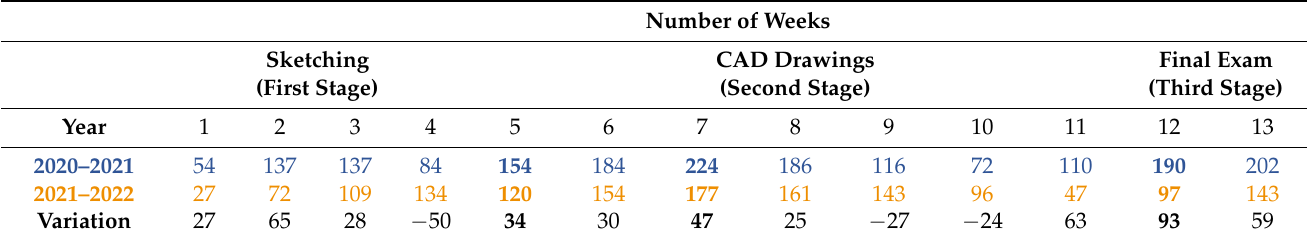
Table 3. Variation of the number of views per week for two time periods per module step.